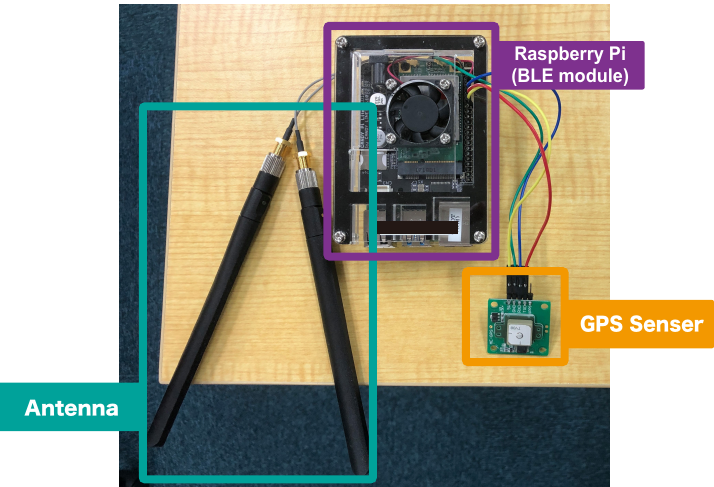
Figure 2. The sensing